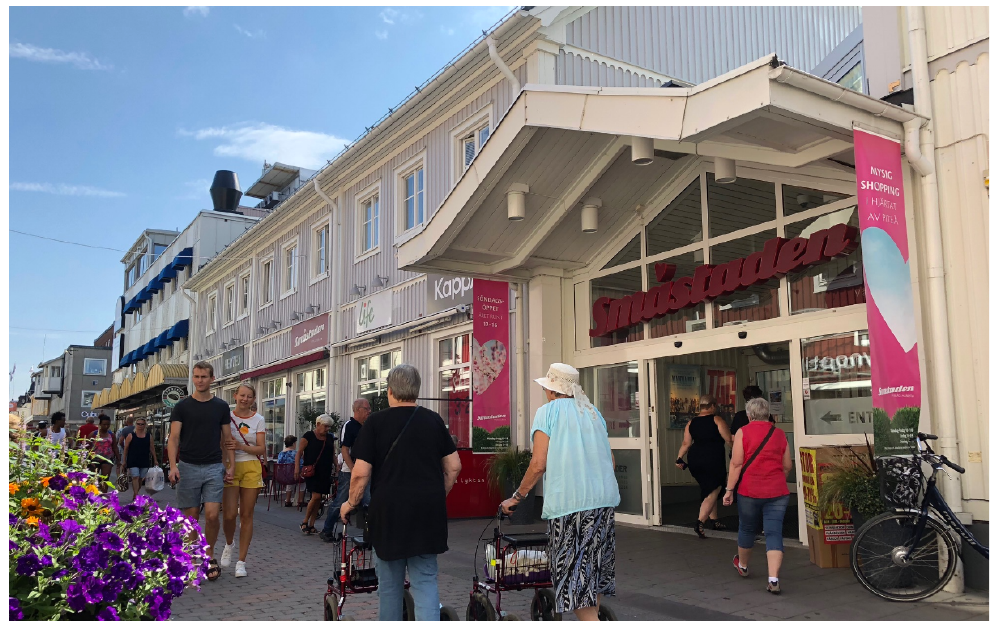
Figure 5. Shopping mall in Piteå (photographer Johanna